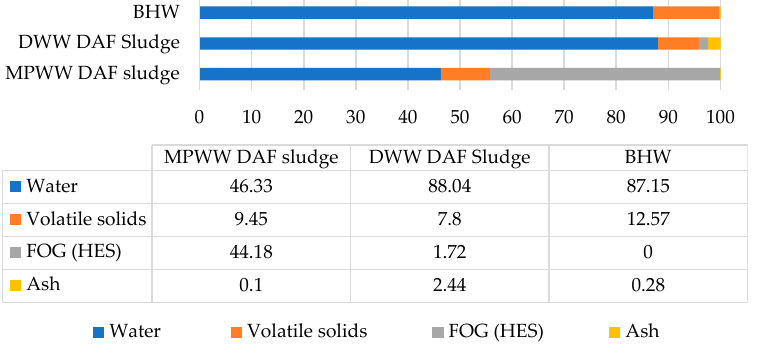
Figure 2. Chemical characteristics of substrates used in AD experiments (concentration represented in w / w %).